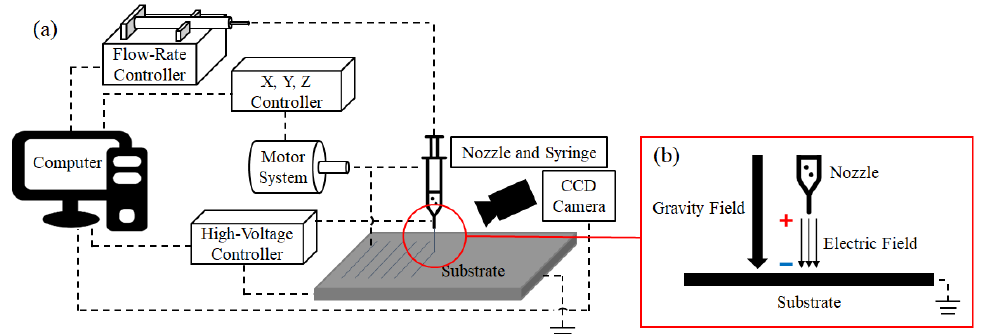
Figure 2. ( a ) System schematic diagram of EHD ink-jet printing. ( b ) Principle of EHD ink-jet printing.